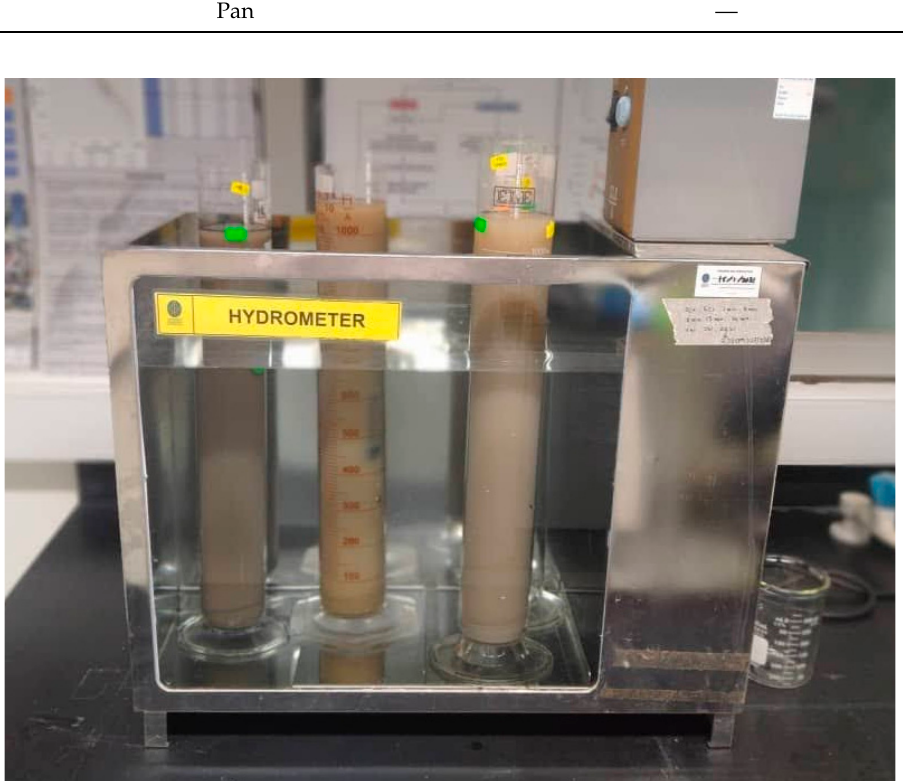
Figure 4. Image analysis workflow diagram for identifying pore spaces in thin sections. The first step is identifying pore spaces based on the color difference using thin sections,the second step is to separate the blue color, the third step is to create a binary images with the 0 value for pore spaces and the 1 value for minerals, and the last step was to classify the clusters of the 0 value spots to calculate their areas, and axes lengths.